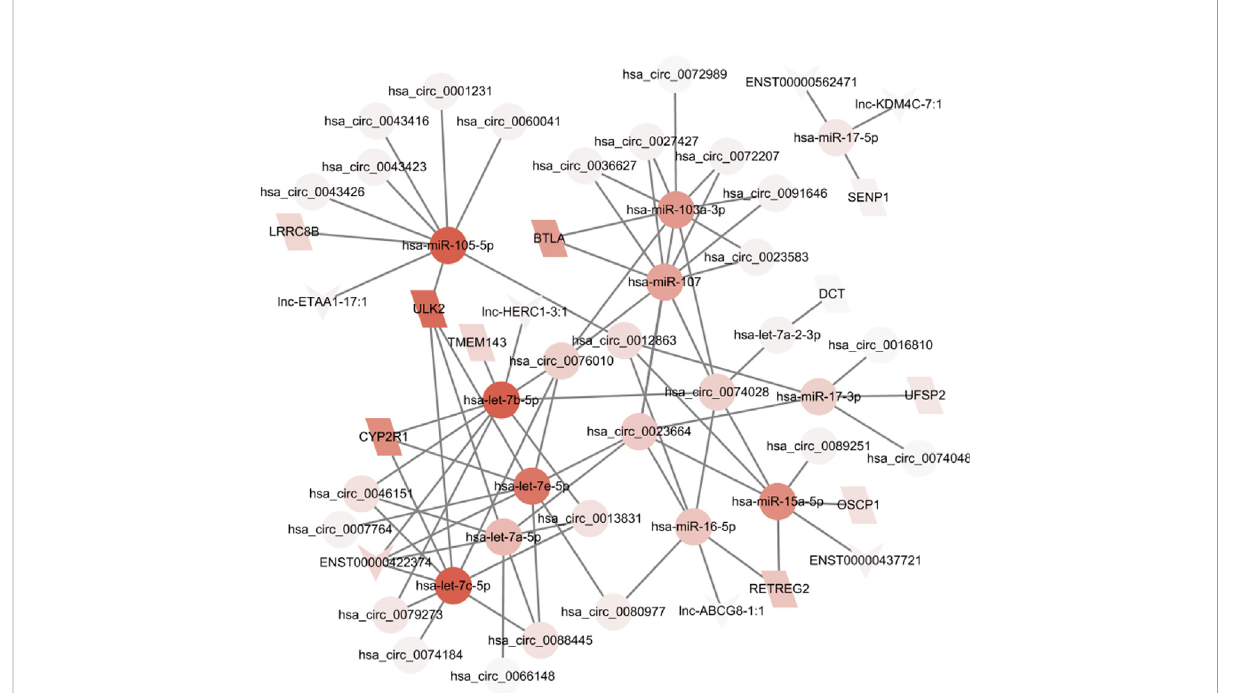
FIGURE 5 A ceRNA network based on differential genes was constructed which involves 33 lncRNAs/circRNA, 11 mRNAs, and 12